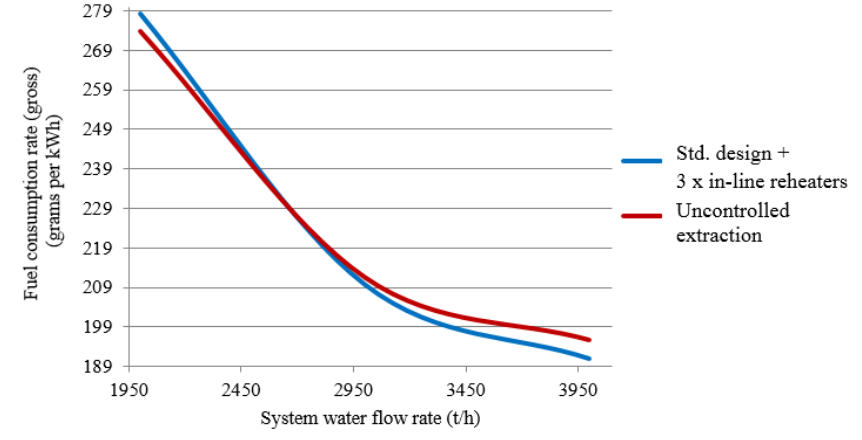
Figure 7. Plots of specific fuel-equivalent flow rates as a function of the system water flow rate for generating unit thermal systems at an outdoor air temperature of +3 °C.